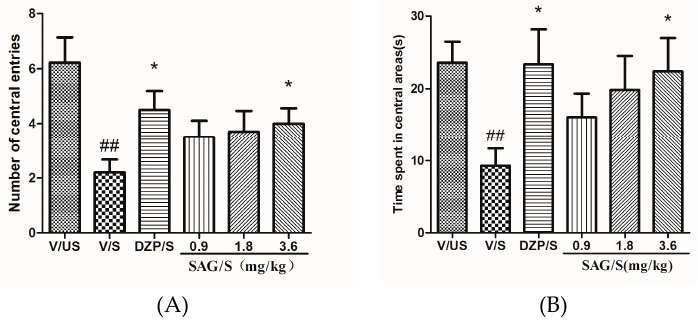
Figure 1. Effect of ( − )-syringaresnol-4- O - β - D -apiofuranosyl-(1 → 2)- β - D -glucopyranoside (SAG) on the number of central entries and the time spent in central areas in the open field test in rats. ( A ) Number of central entries; ( B ) Time spent in central areas. Bars represent mean ± SEM. ## p < 0.01 vs. vehicle/unstressed group; * p < 0.05 vs. vehicle/stressed group. One-way ANOVA with Student-Newman-Keuls post hoc test.